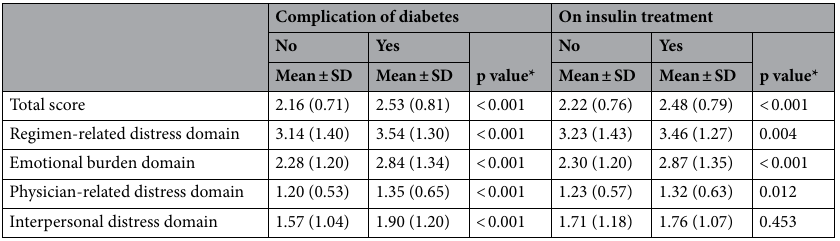
Table 3. Diabetes distress score among patients with or without complications and insulin treatment are assess as a measure to see scale’s discrimination capacity (n = 1184). *p values are generated using independent t test.